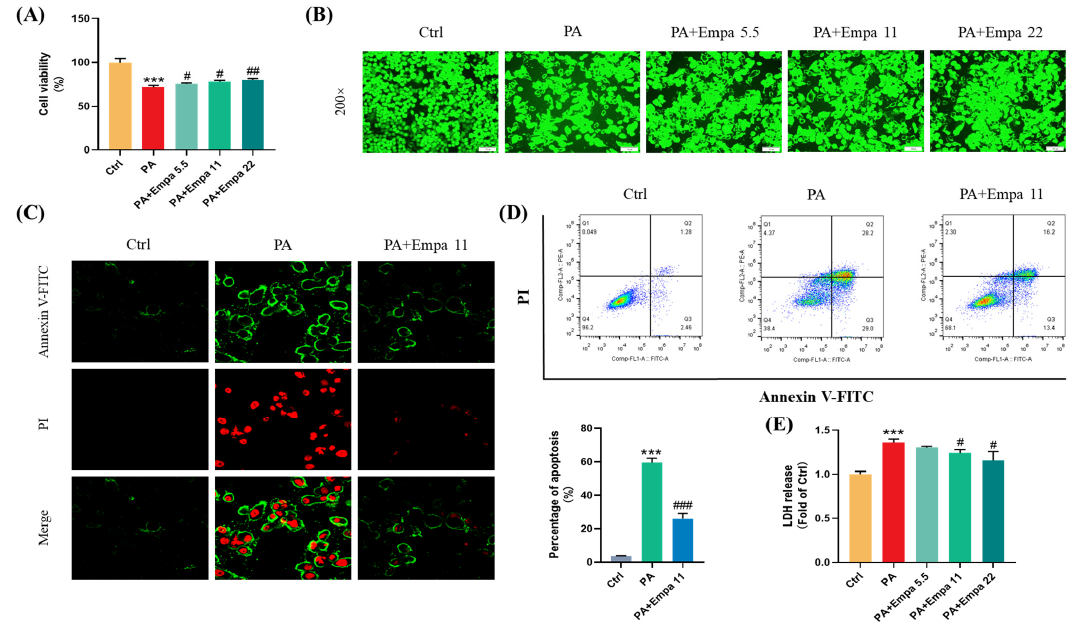
Figure 1. Empa improved cell viability and attenuated apoptosis of LO2 cells in a PA-induced lipotoxicity model. ( A ) Effect of Empa (5.5-22 μ M) on cell viability of LO2 cells treated with 0.5 mM PA for 24 h, and which was analyzed by MTT assay. ( B ) Representative images of live cells stained with CCK-F. ( C ) Representative confocal microscope im- ages of LO2 cells stained with Annexin V-FITC/PI. ( D ) Quantification analysis of apoptosis in LO2 cells by flow cy- tometry. ( E ) LDH level in the culture supernatant of LO2 cells treated with PA and Empa. All data are expressed as mean ± SD ( n = 3). *** p < 0.001 versus Ctrl. # p < 0.05, ## p < 0.01, and ### p < 0.001 versus PA. Ctrl, PA-untreated